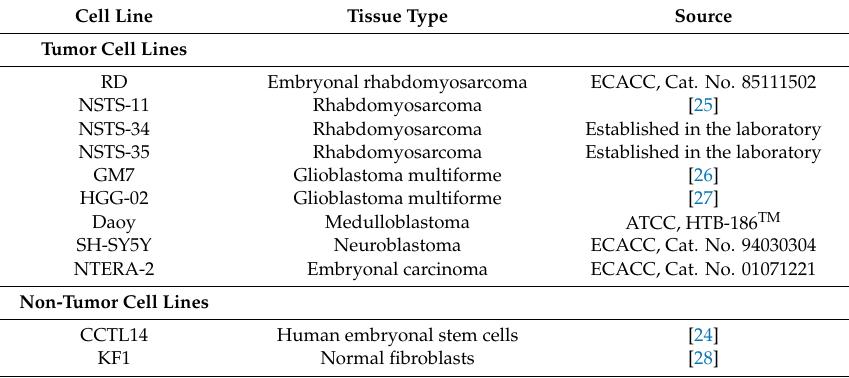
Table 1. Description of cell